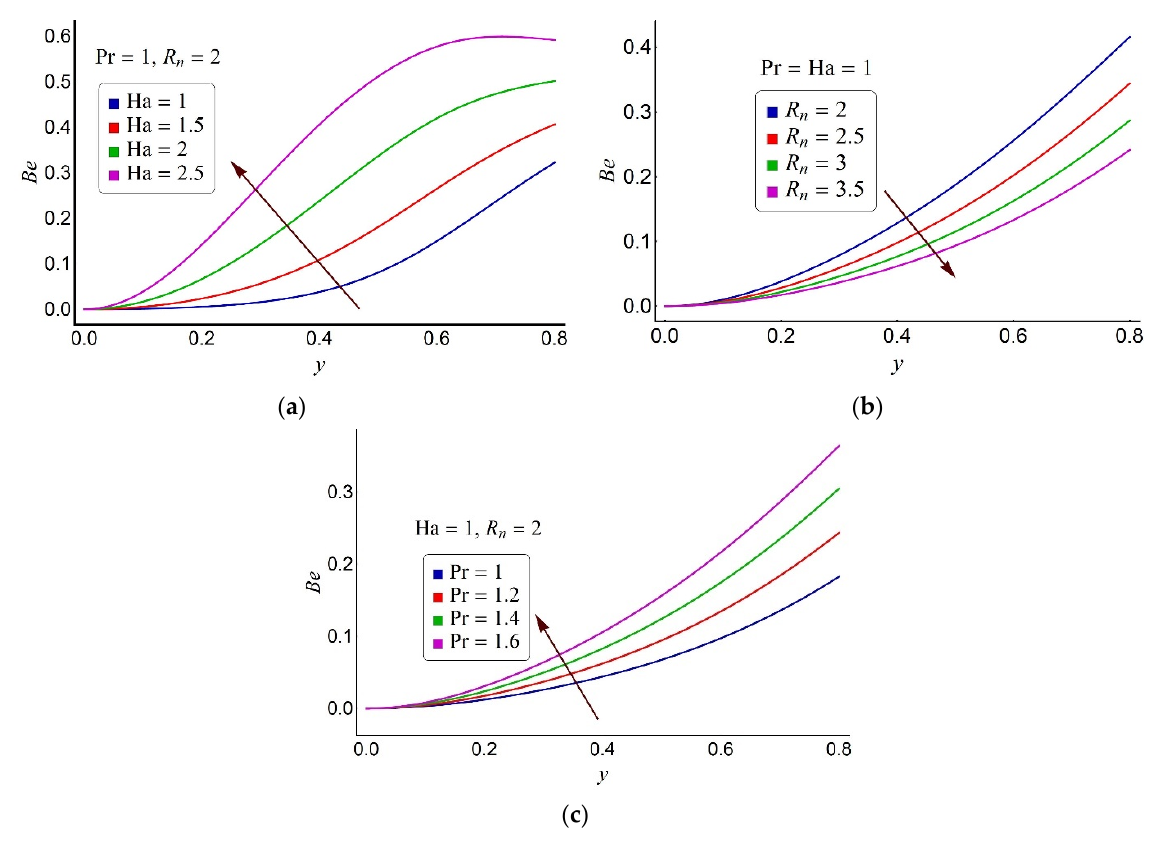
Figure 7. Alterations in the Bejan number distribution for distinct values of ( a ) the Hartmann number (Ha), ( b ) the thermal radiation number ( R n ), and ( c ) the Prandtl number (Pr).